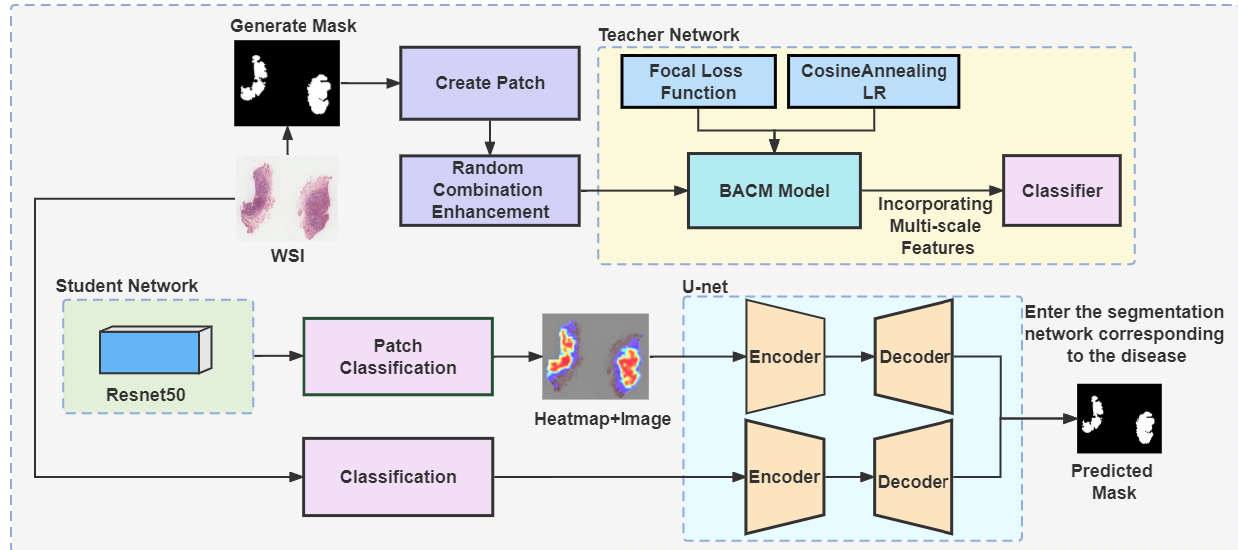
Figure 1. General flow-chart: the data were augmented using random combinatorial data processing; we proposed Mac-ResNet and used knowledge distillation to streamline the network. In addition, three segmentation networks were trained to learn the knowledge of three diseases and input to the corresponding class of segmentation networks to achieve the diagnosis of diseases as well as fast localization of lesion